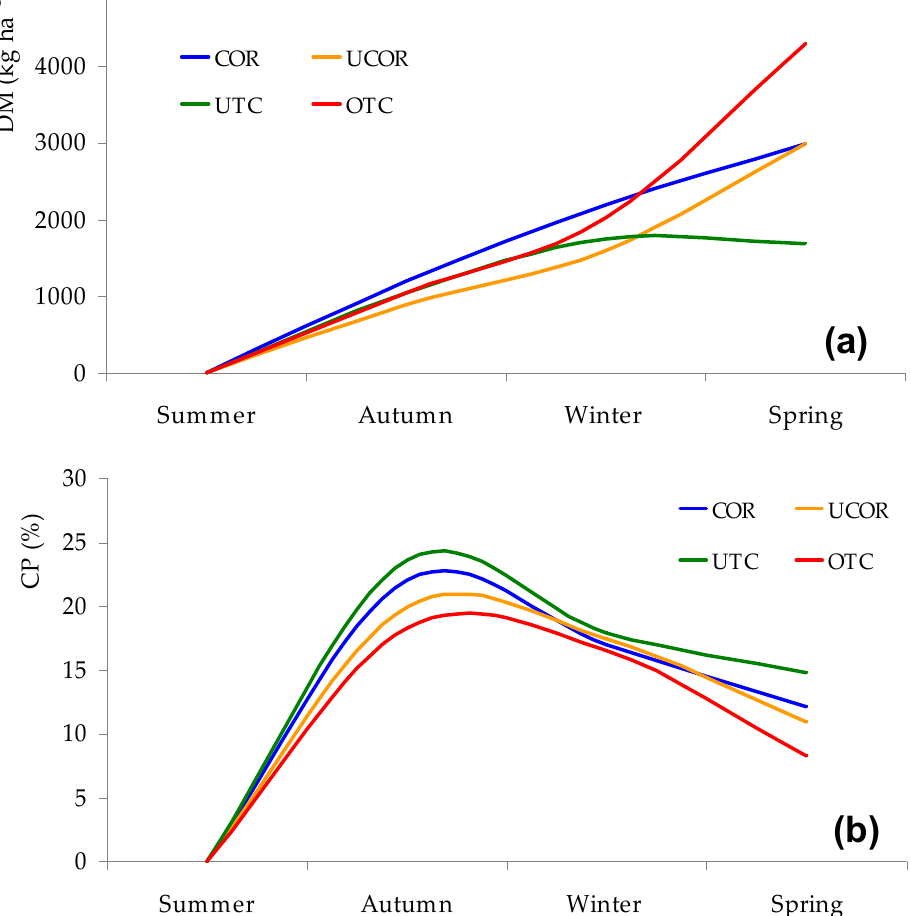
Figure 4. Evolution of pasture dry matter (DM; ( a )) and crude protein (CP; ( b )) in the experimental field: average values of 2018/2019 and 2019/2020 vegetative cycles.